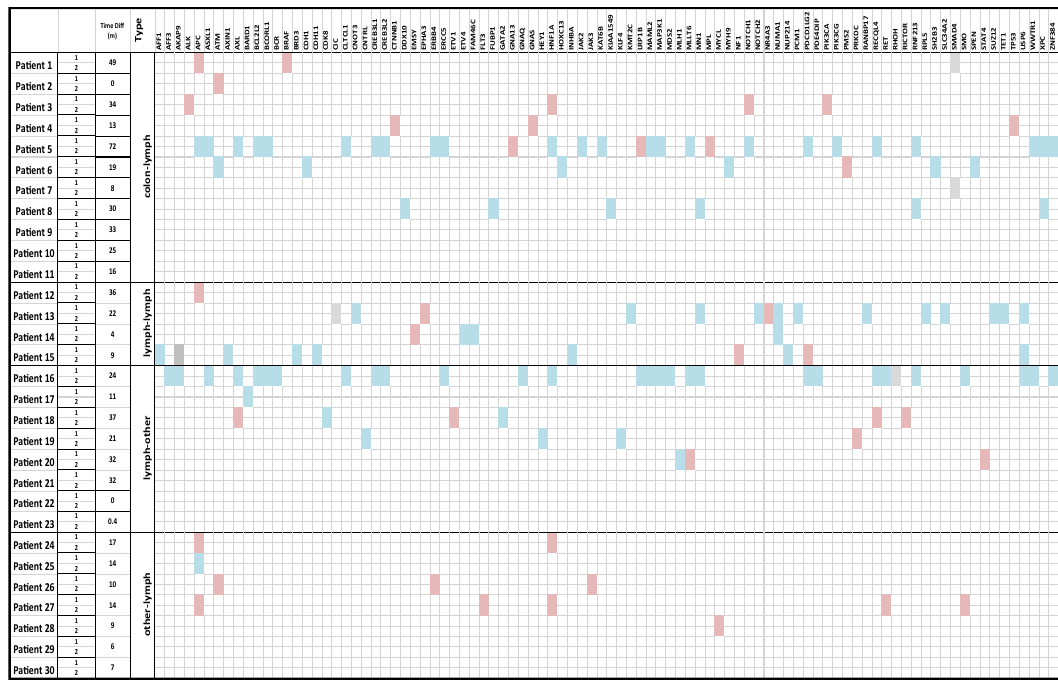
Fig. 6 Oncoprint of paired samples. A total of 30 patients with lymph node samples were identi fi ed to have serial tumor samples pro fi led. 11 patients had one colon tumor and one lymph nodes sample pro fi led; 4 patients with two lymph nodes samples pro fi led; 15 tumors with one lymph nodes sample and one distant metastasis pro fi led. Red: acquisition (gain of function) of mutations; blue: loss of function